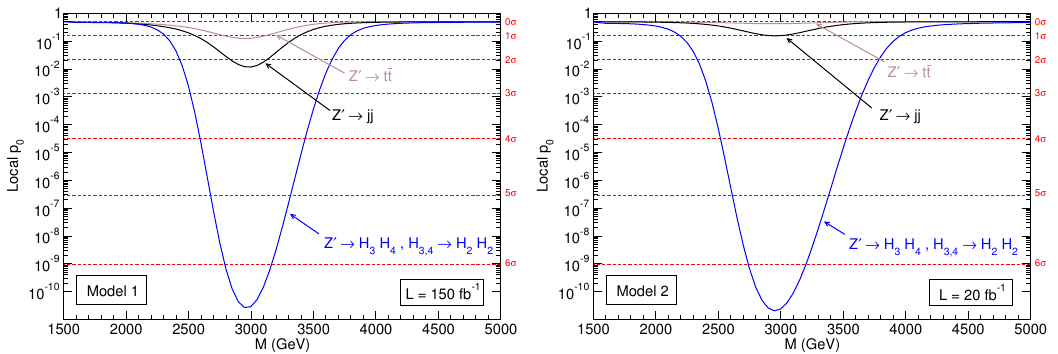
Figure 7 . Expected local p -value for the Z 0 signal in the various searches, for scenario 2 of model 1 (left) and model 2